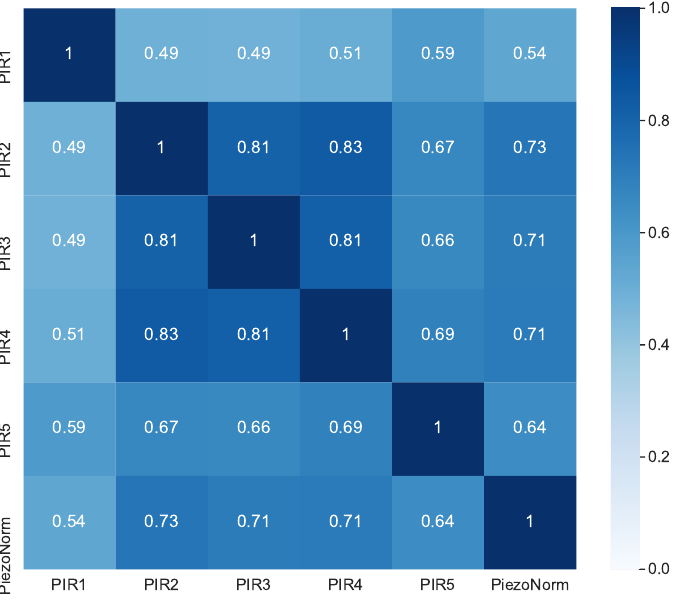
Figure 6. Correlation heatmap of the PIR and piezoelectric sensors with a sliding window. The results showed a very high correlation among the PIR sensors of up to 0.83. This is understandable considering that the five PIR sensors had different fields of view, and the pairs of sensors that both captured a portion of the bed in its field of view were the ones with higher correlation. Likewise, there was a very high correlation of up to